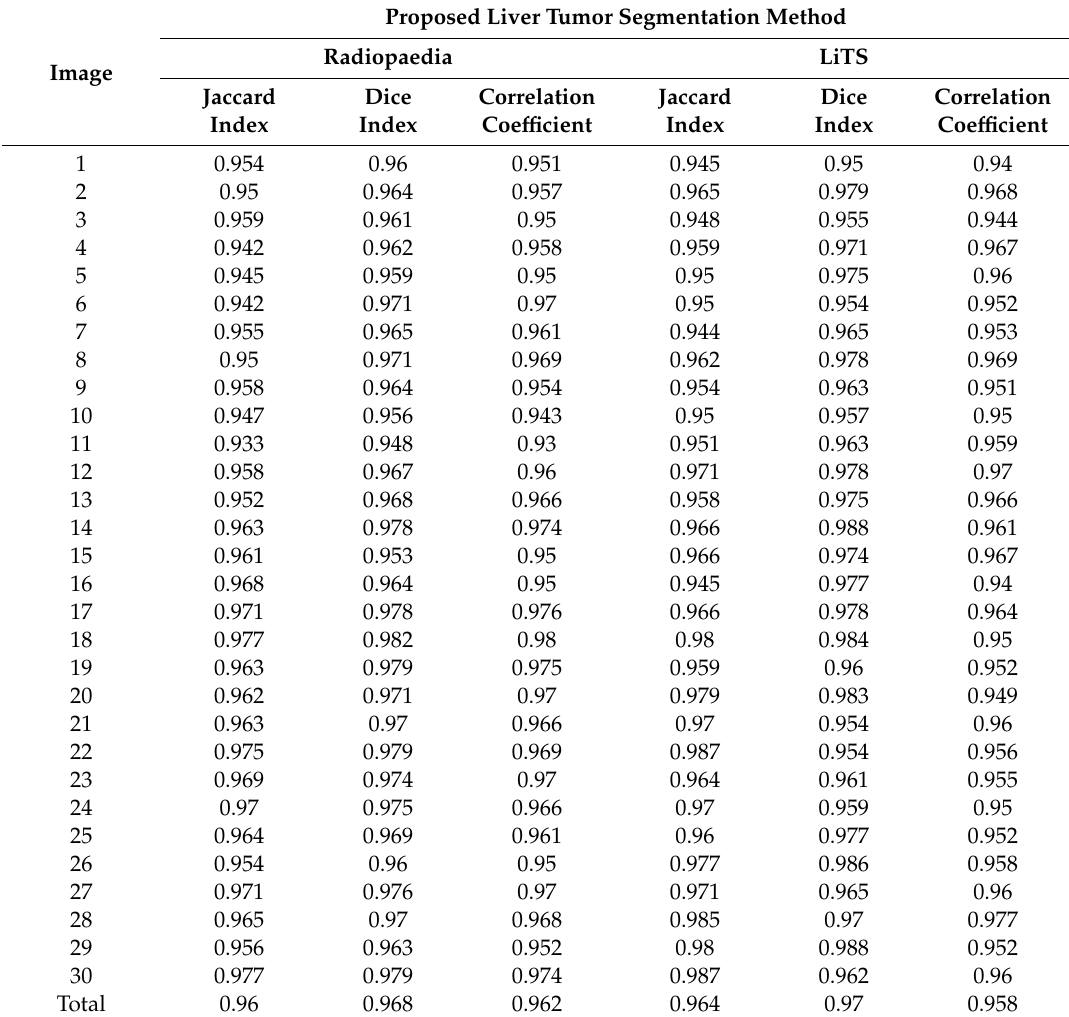
Table 6. The application results of the SegNet-UNet-ABC algorithm for liver lesion segmentation.